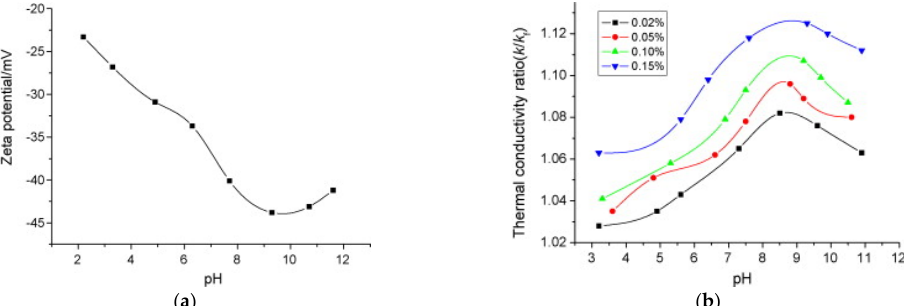
Figure 10. Effect of pH on ( a ) Zeta potential and ( b ) thermal conductivity of Cu-H2O suspensions with SDBS surfactant at 0.05 wt% [29].